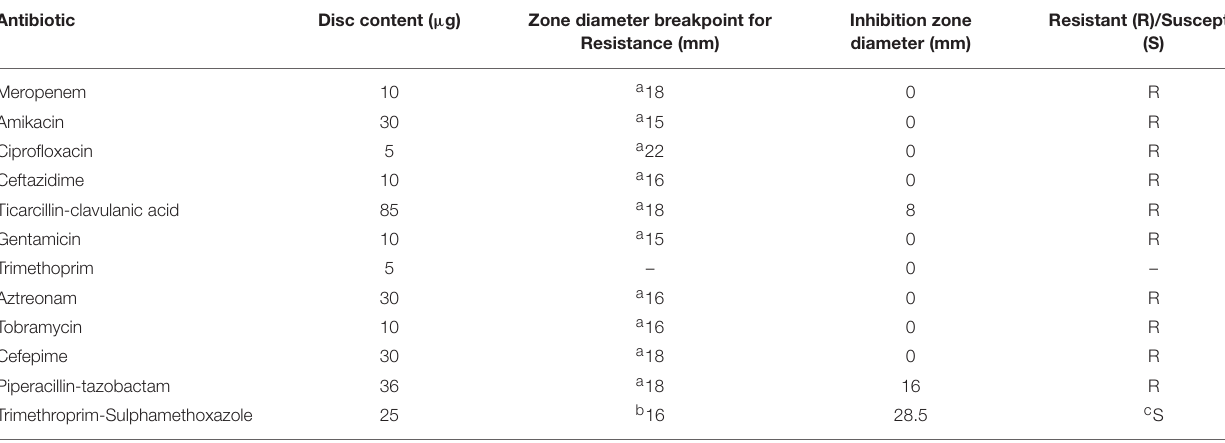
TABLE 1 | P. pnomenusa antibiotic susceptibility testing by disk diffusion assay. Antibiotic Disc content ( µ g) Zone diameter breakpoint for